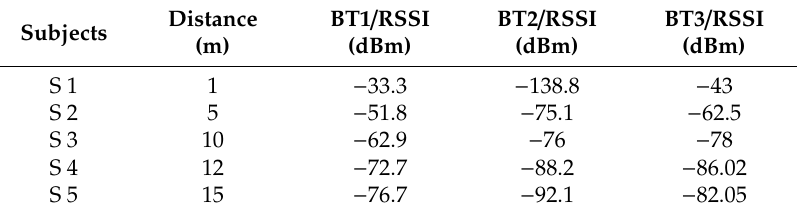
Table 4. RSSI levels for BT 1–3.